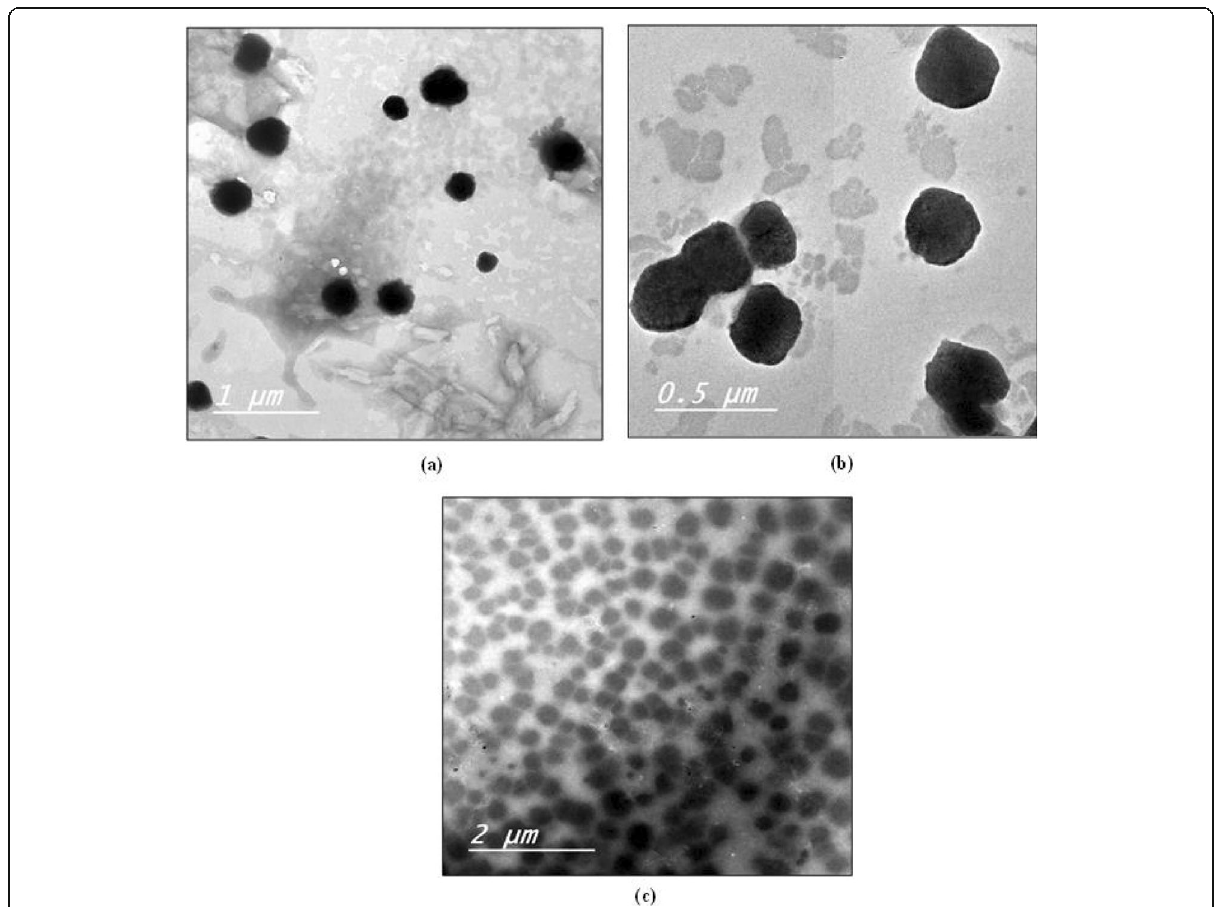
Fig. 1 Transmission electron photomicrographs of prepared MEs: a ME-F1, b ME-F2, and c